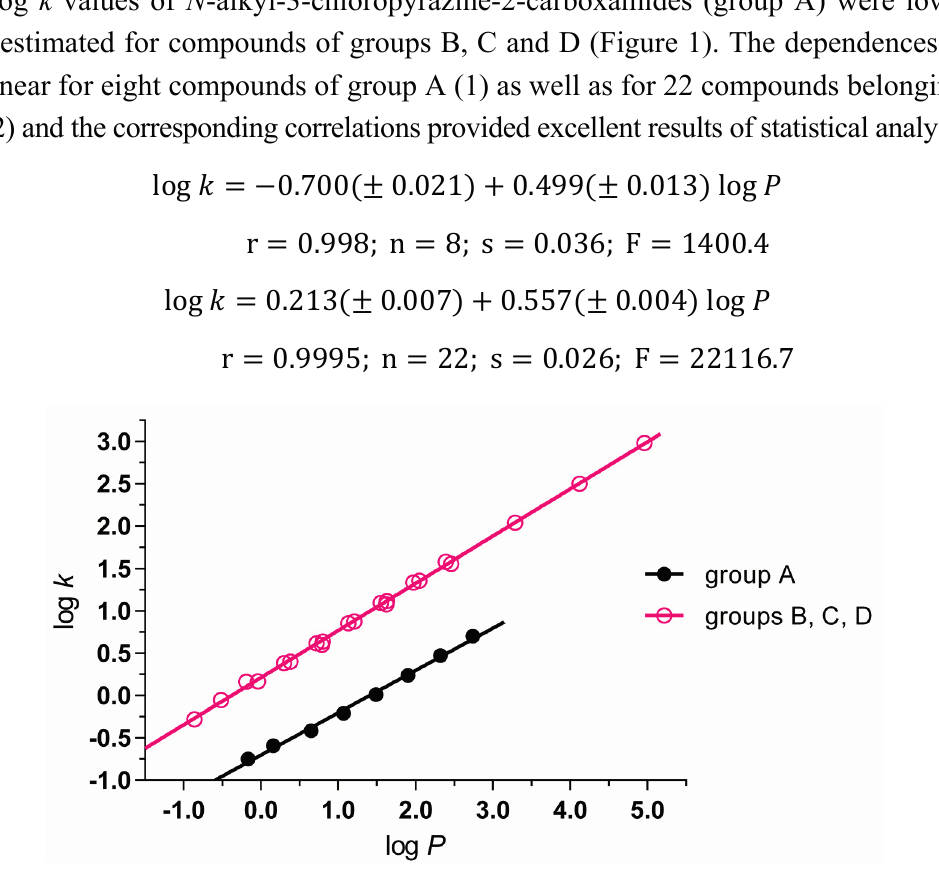
Figure 1. Plot of experimentally measured log k parameter on calculated log P